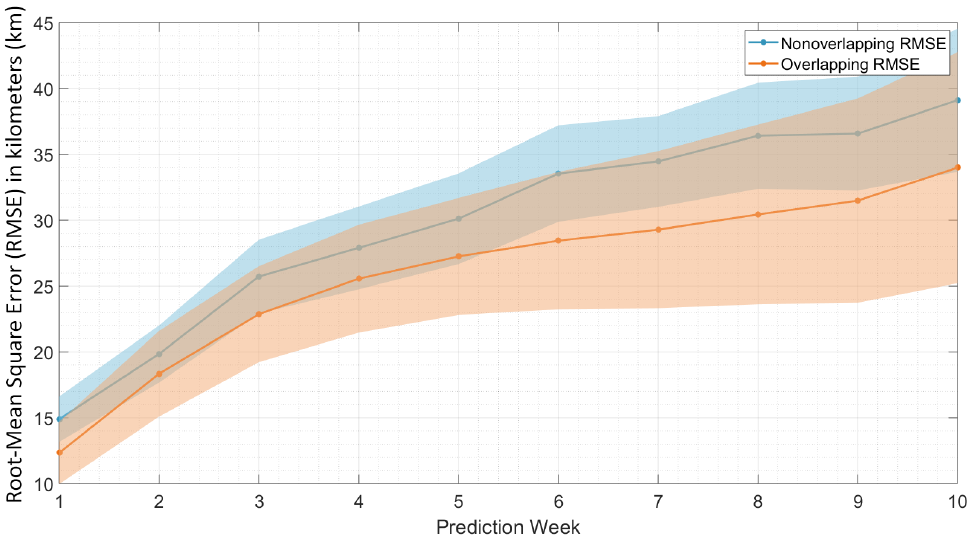
Figure 5. RMSE dF mean (solid line) and standard deviation (shaded area) for both the non- overlapping model (blue) and the overlapping (red) partition models. Note that while the resolution of our data is 1/25 or 4 km, a 5 km difference is still significant as it is a 12% improvement on